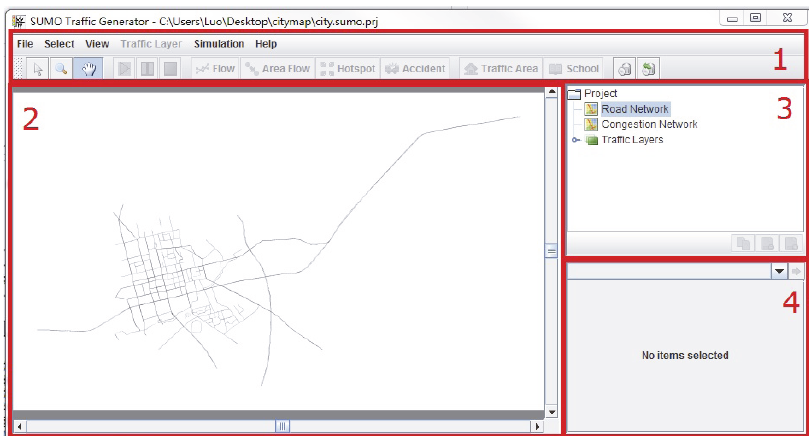
Figure 3: The interface of our framework for performance evaluation.